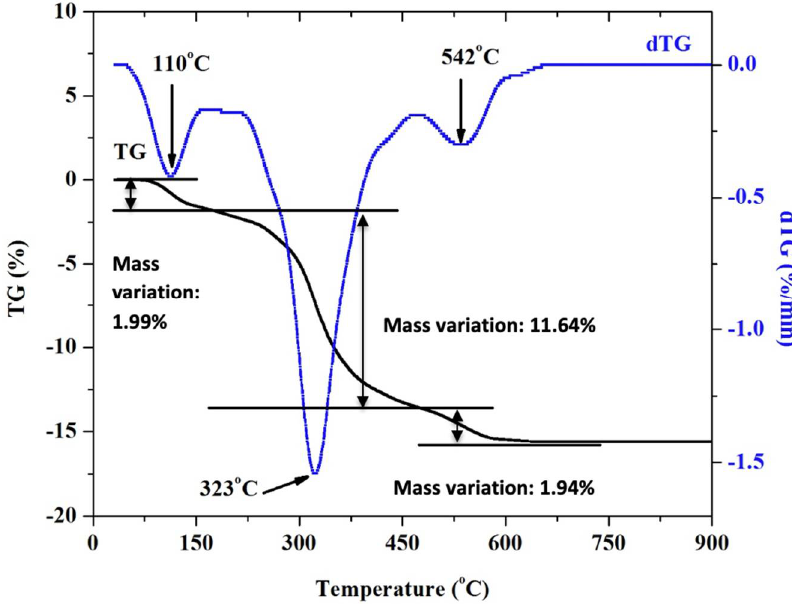
Figure 2. TG-DTG curve of red mud.